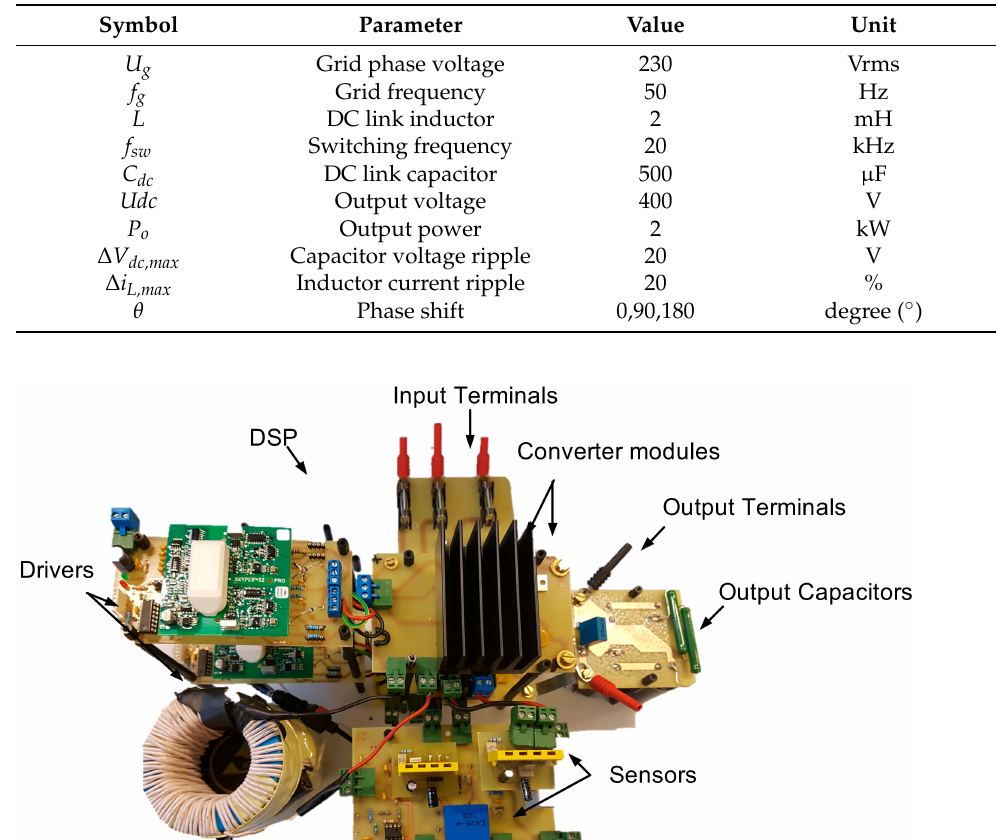
Table 5. Case Study Specification.